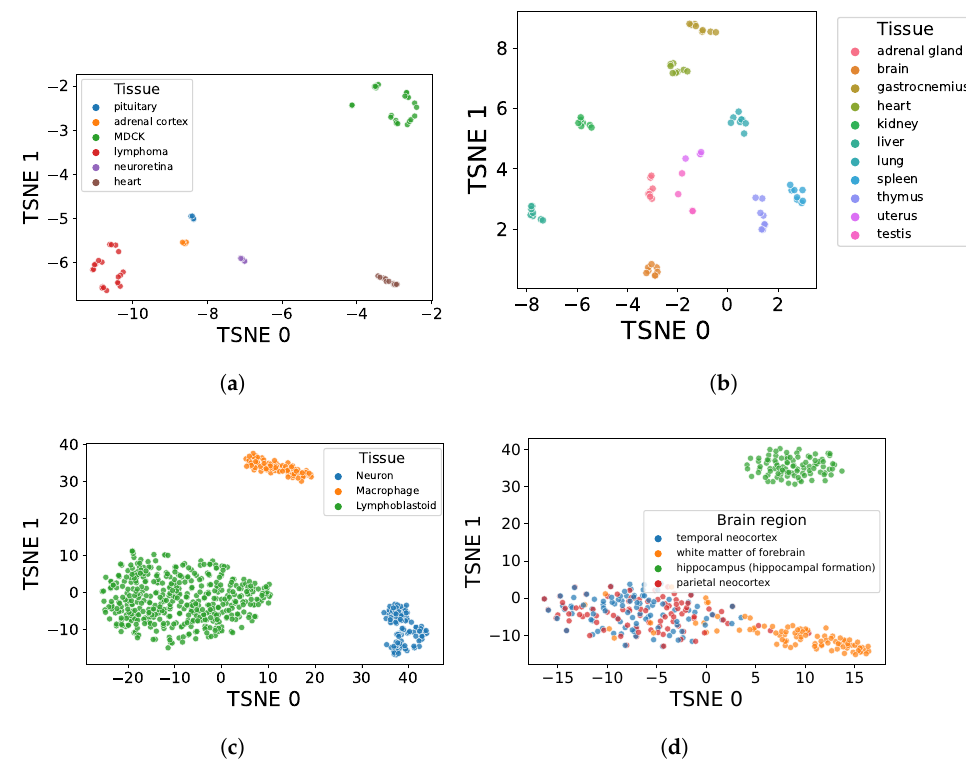
Figure A1. TSNE plots for the C. familiaris , R. norvegicus and H. sapiens RNA-seq dataset. Samples are clustered by tissue-type, and do not exhibit an important batch effect; ( a ) C. familiaris ; ( b ) R. norvegicus ; ( c ) H. sapiens ; ( d ) H. sapiens -Alzheimer/Control.